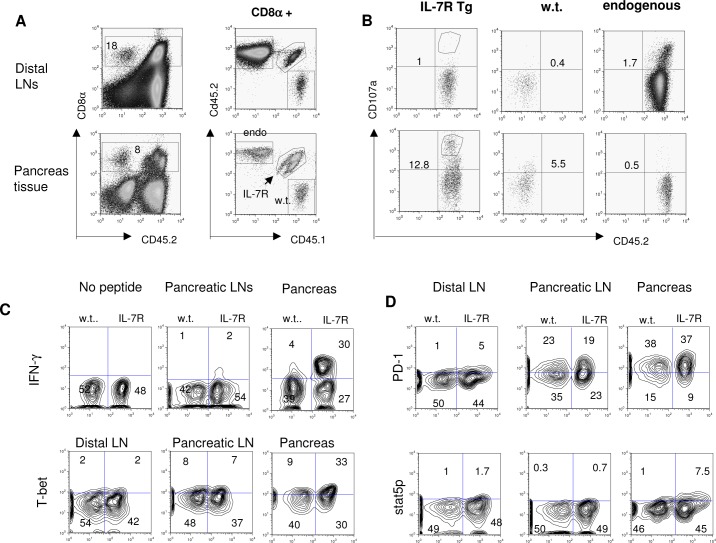
Over-expression of IL-7R enhances OT-I T cell effector function in the pancreas.A and B: 0.5 x 106 purified CD45.1+ w.t. OT-I T cells were mixed with 0.5 x 106 purified CD45.1+/CD45.2+ IL-7R Tg OT-I T cells and transferred into RIP-mOVA mice (n = 5). At day 6 after the transfer, pancreata from the recipients were pooled and islets were separated. Infiltrating lymphocytes were isolated from the islets as described in Material and Methods. 5x104 viable cells were recovered. Endogenous T cells (endo), w.t. and IL-7R Tg OT-I T cells were distinguished by their congenic markers (A) and their surface exposure of CD107a was determined in B by flow cytometry. Pooled T cells from distal LNs were used as an internal negative control. C and D: Intracellular expression of IFN-γ, T-bet, pSTAT5, and surface expression of PD-1 by OT-I T cells recovered from different sites (pooled from 5 mice in each experiment). In order to detect IFN-γ production, pooled lymphocytes were re-stimulated with OVA peptide for 5 hours before fixation. The results from A-D are representative of two experiments.